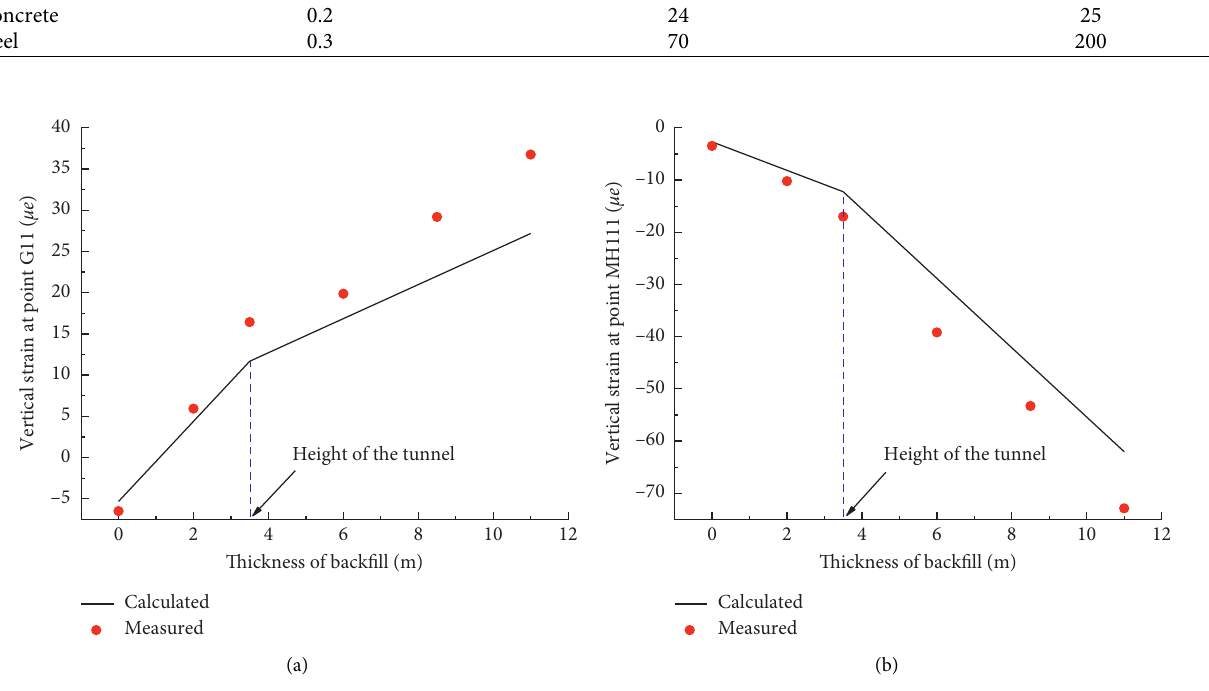
Figure 4: Comparison between calculated and measured concrete strain: (a) G11 and (b)